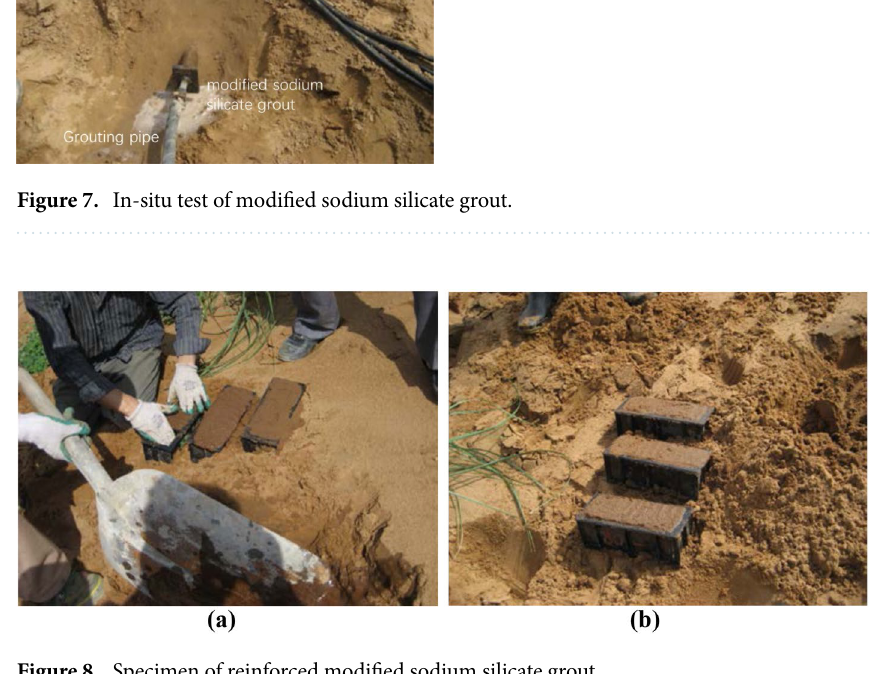
Figure 8. Specimen of reinforced modified sodium silicate